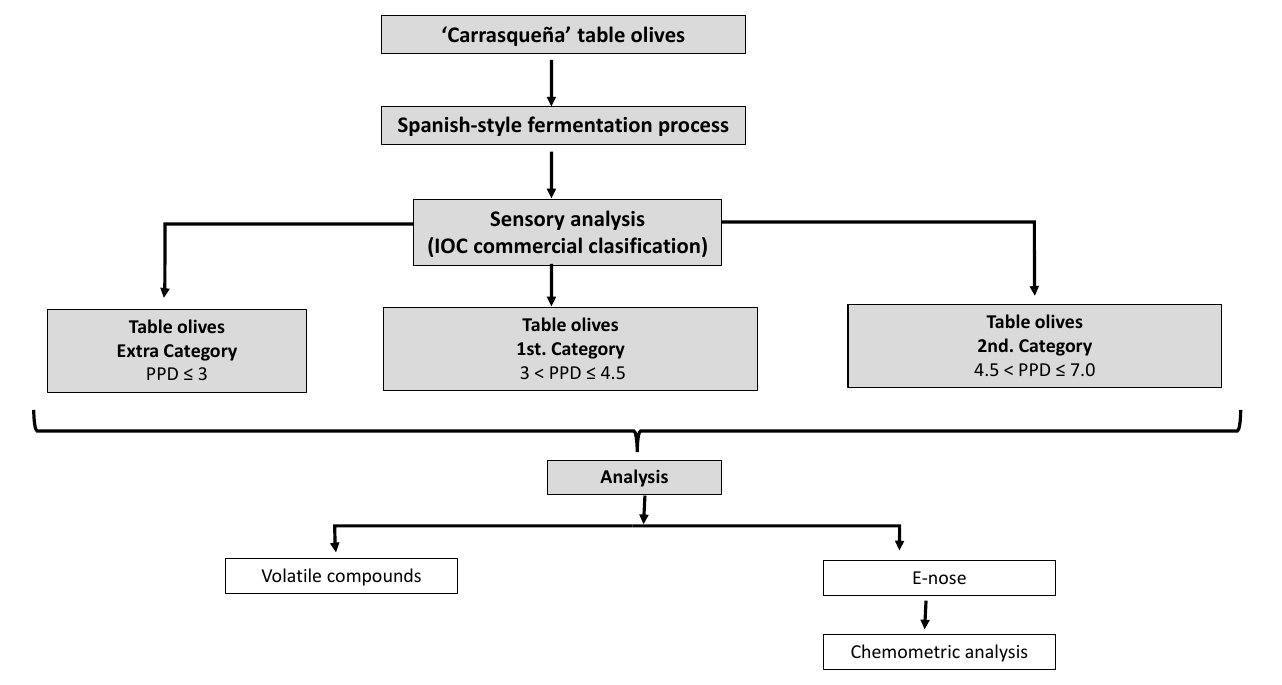
Figure 1. Diagram of the overall experiment design.